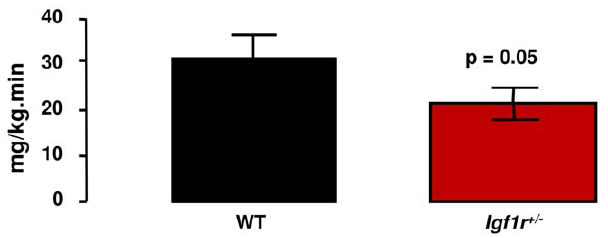
Figure 5. Peripheral Insulin Sensitivity. Peripheral (muscle) insulin sensitivity was measured with a 90 min hyperinsulinemic euglycemic clamp performed in 4 WT and 5 Igf1r + / 2 females, all 25 months old. Bars represent the average 6 SE glucose infusion rate during the last 20 min of the clamp. A student’s t-test was used to compare the infusion rates between the two groups, averaged over the 20 min period for each